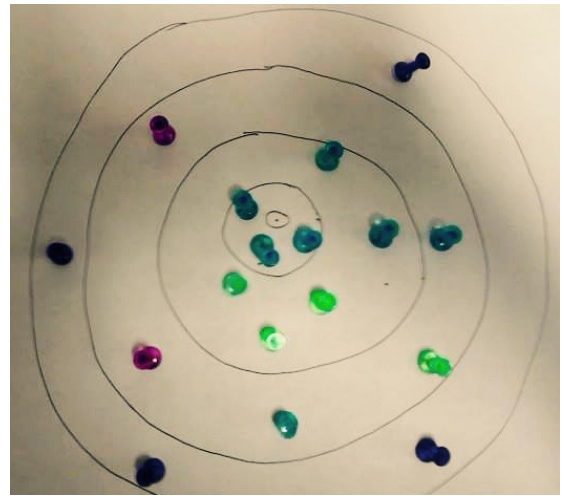
Figure 1. Sample of A2